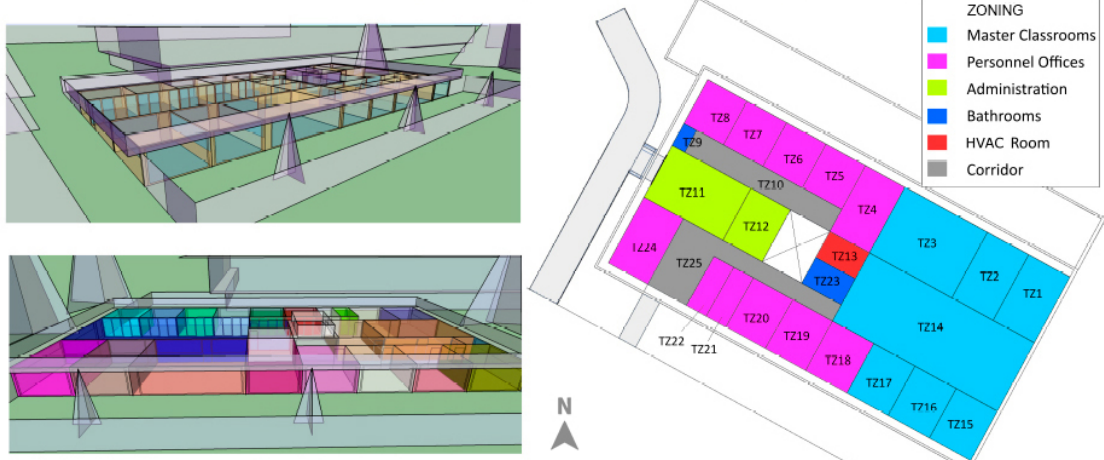
Figure 2. Energy model and zoning map of the Office building, School of Architecture (University of Navarra).